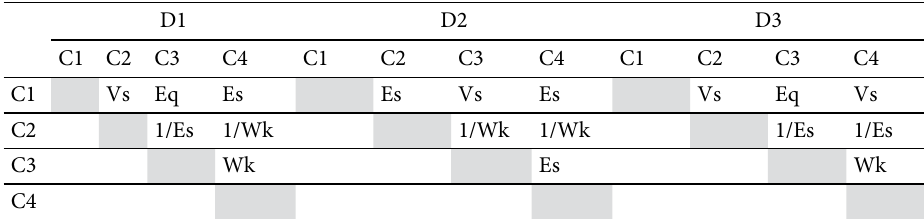
Table 3. Decision maker’s evaluations for criteria